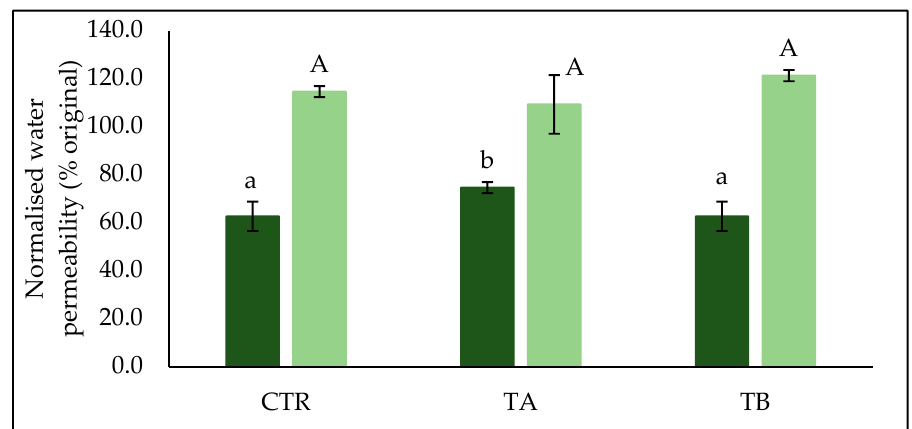
Figure 5. Normalised water permeability (% original value) of membrane measured before ( ■ ) and after ( ■ ) membrane cleaning process. Values are the means ± standard deviations of analysis from triplicate runs at each treatment. Different lowercase and uppercase letters on the bar graphs indicate significant differences ( p < 0.05).